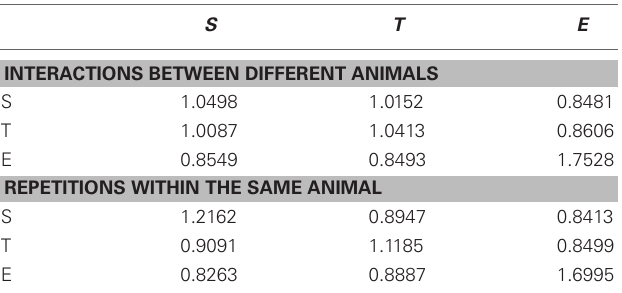
Table 2 | Transition index for sequence of two maneuvers estimated as the probability of transition from maneuver 1 to maneuver 2 divided by the occurrence of the maneuver